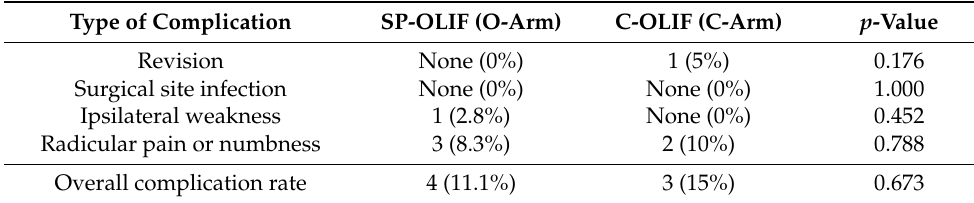
Table 6. Surgery-related